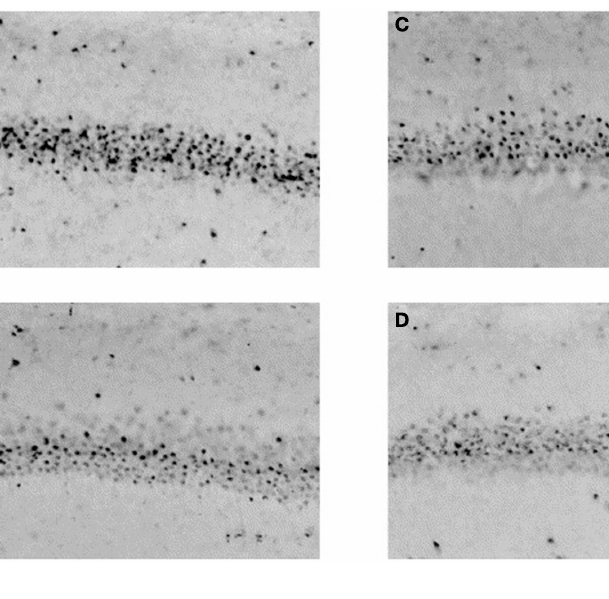
FIGURE 2 | GABA agonists affect the development of the neonatal brain . Muscimol, a potent selective agonist for the GABA A receptor, was administered to neonatal rats on postnatal days 0 and 1, and histologic specimens were obtained on postnatal day 21. Representative photomicrographs illustrate neuronal nuclear antigen-immunoreactive